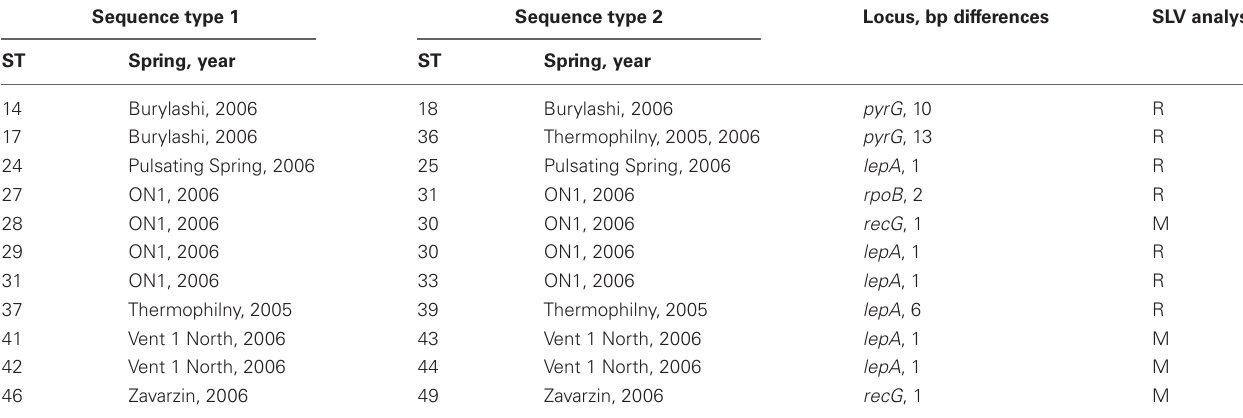
Table 7 | Examination of single locus variants among the T. uzonesis